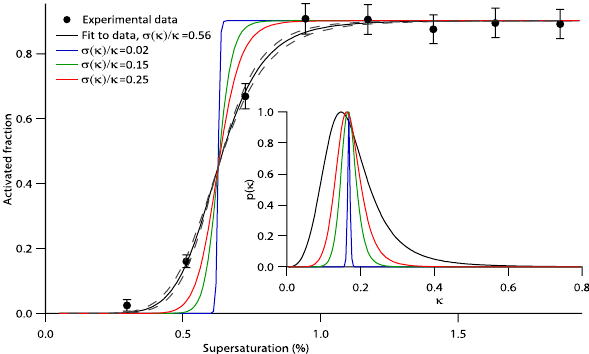
Fig. A1. An example of measured and fitted activation spectrum (60nm dry size, 4/14/2007, 18:55:00) and three examples of activa- tion spectra with different σ ( κ ) values. Corresponding κ distribu- tions are shown in the inset. Error bars represent Poisson counting uncertainties.